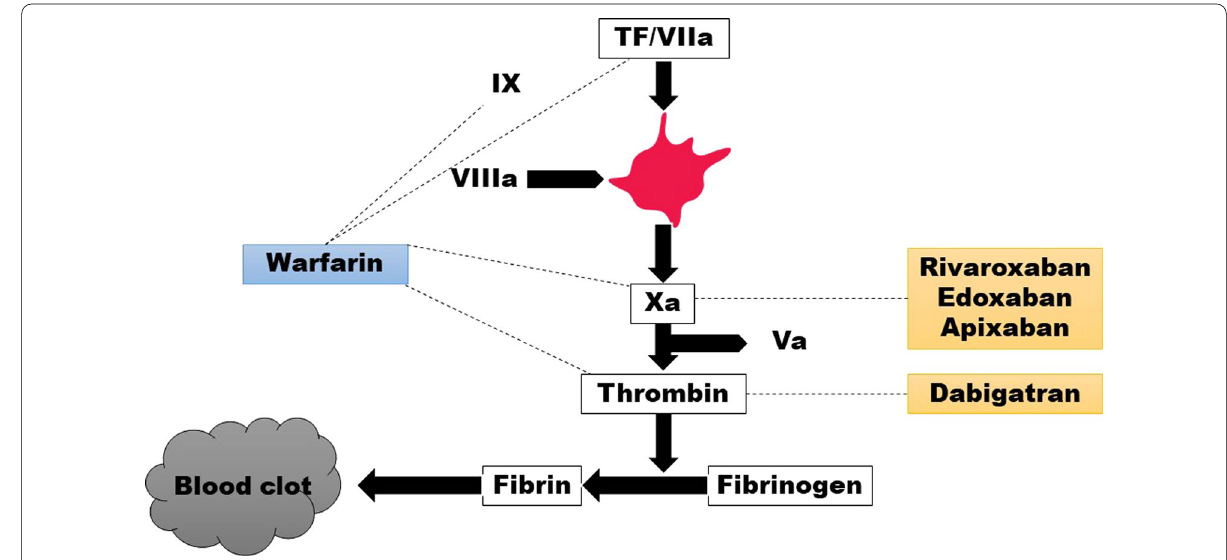
Fig. 1 Sites of action of different anticoagulants